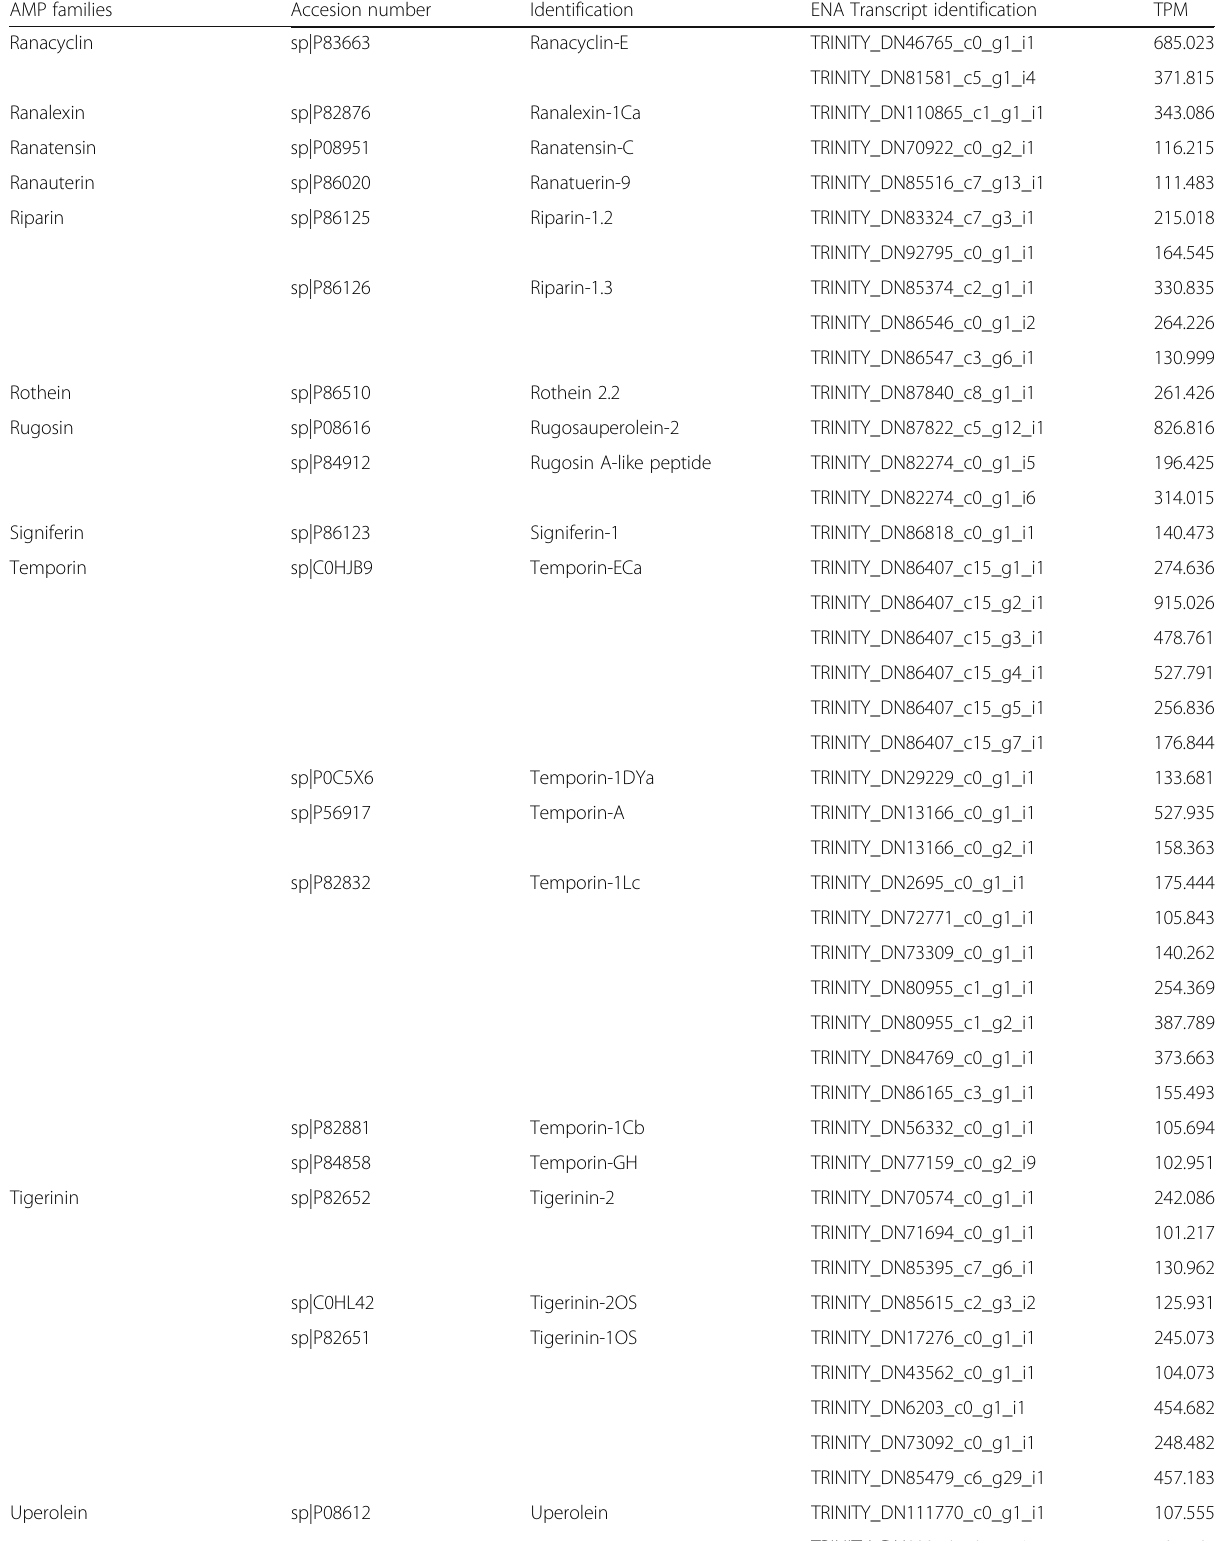
Table 2 List of main antimicrobial peptides from transcriptome (Continued) AMP